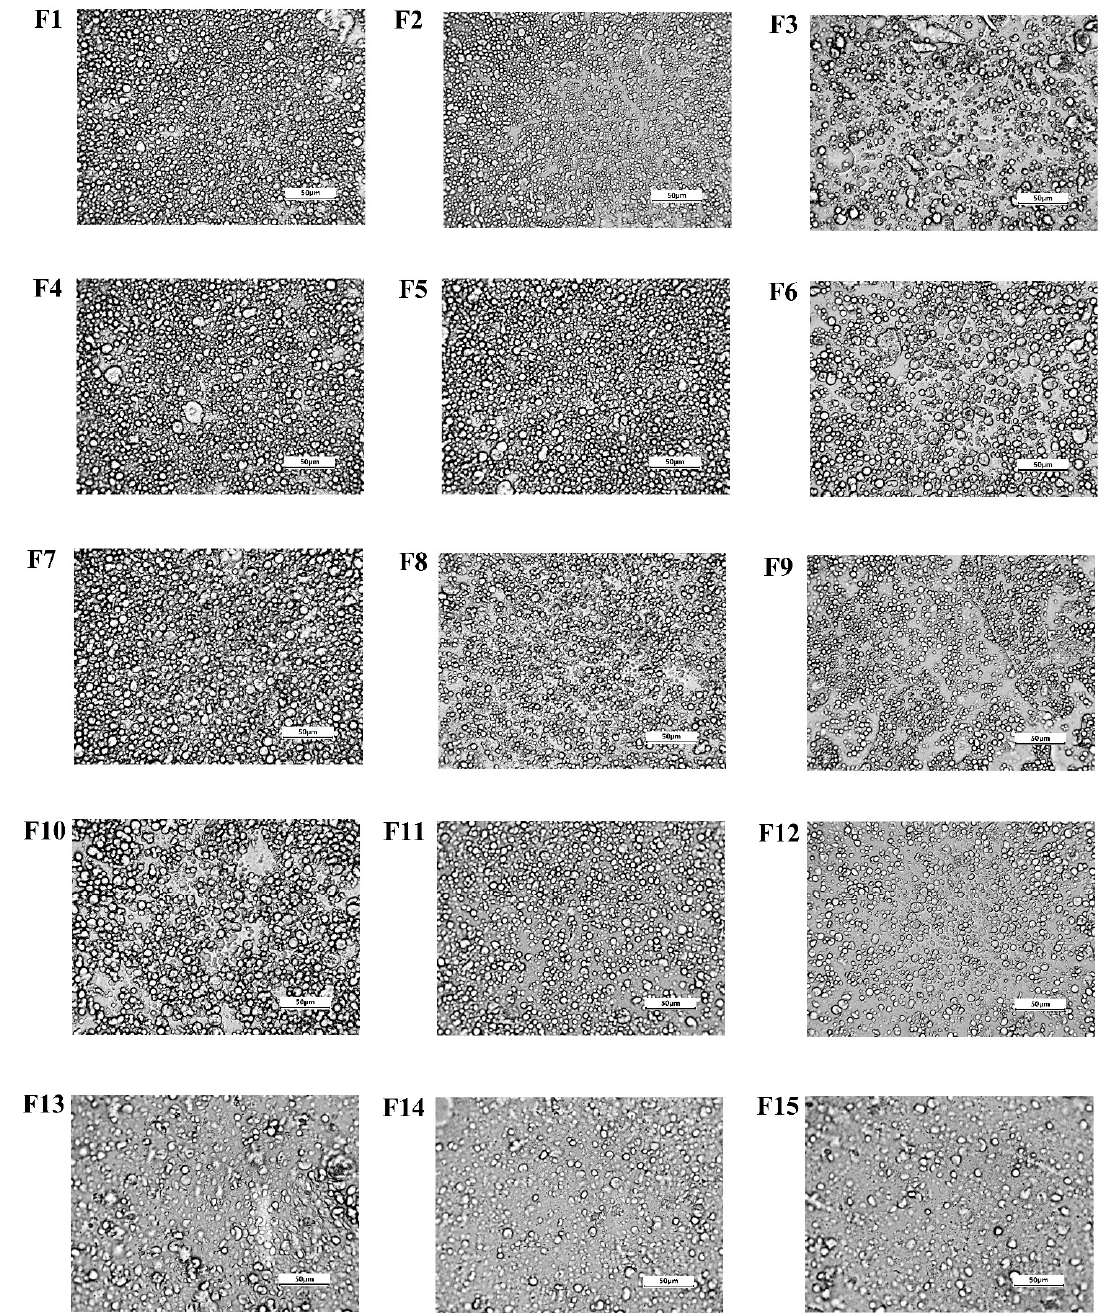
Figure 6. Microstructure of the freshly prepared emulsions. The bar corresponds to 50 µ m.